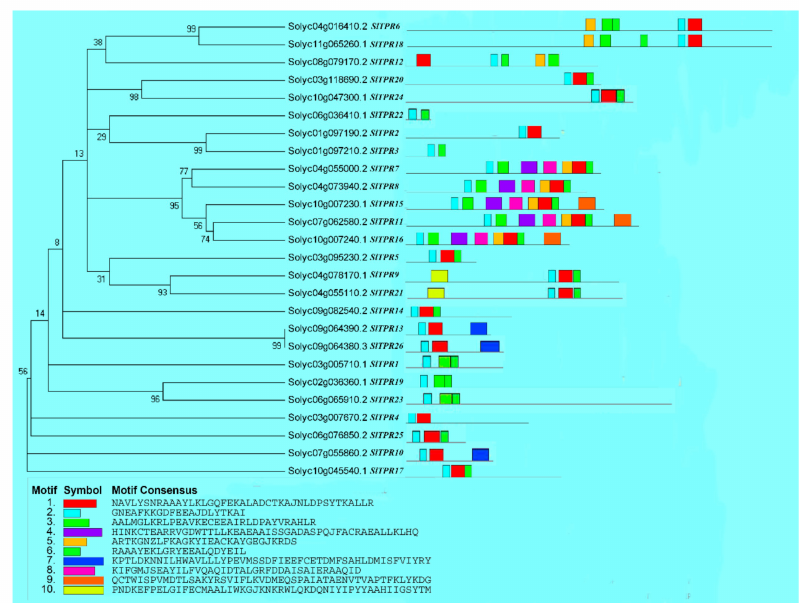
Figure 1. Conserved motifs in tomato TPR proteins. The protein sequences of 26 genes contain 10 conserved motifs, the same conserved motifs among proteins are represent with the same